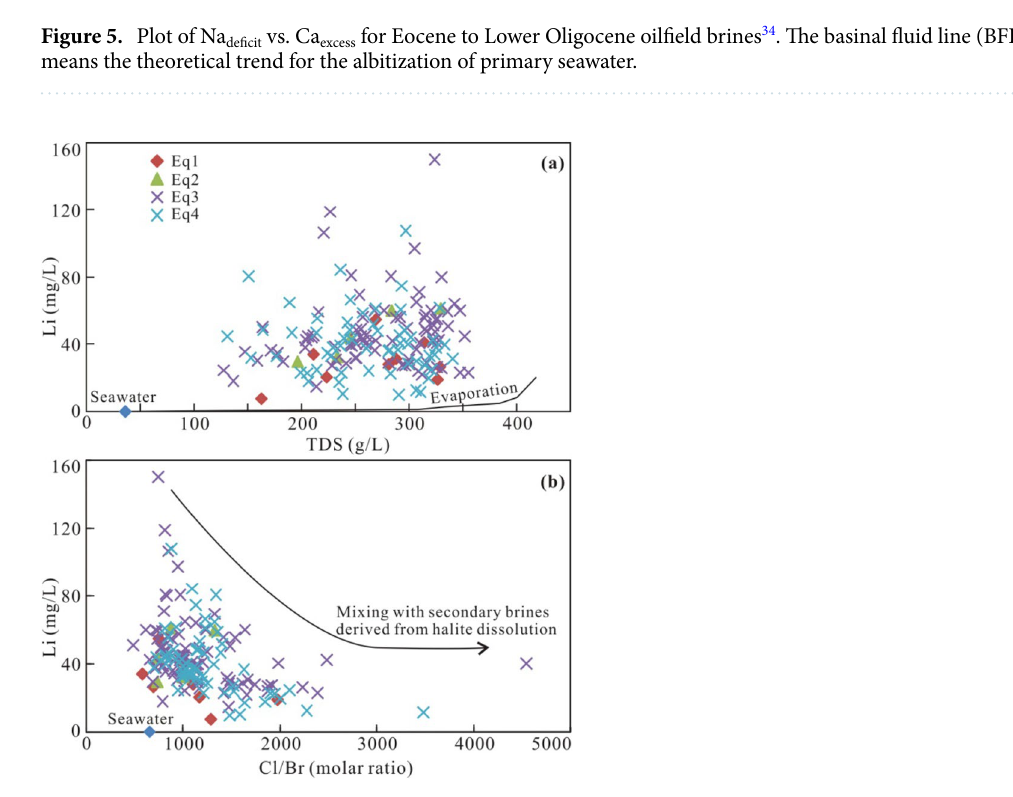
Figure 6. ( a ) Plot of TDS vs. Li concentrations in comparison to the seawater evaporation trajectory 31 . ( b ) Plot of Cl/Br molar ratios vs. Li